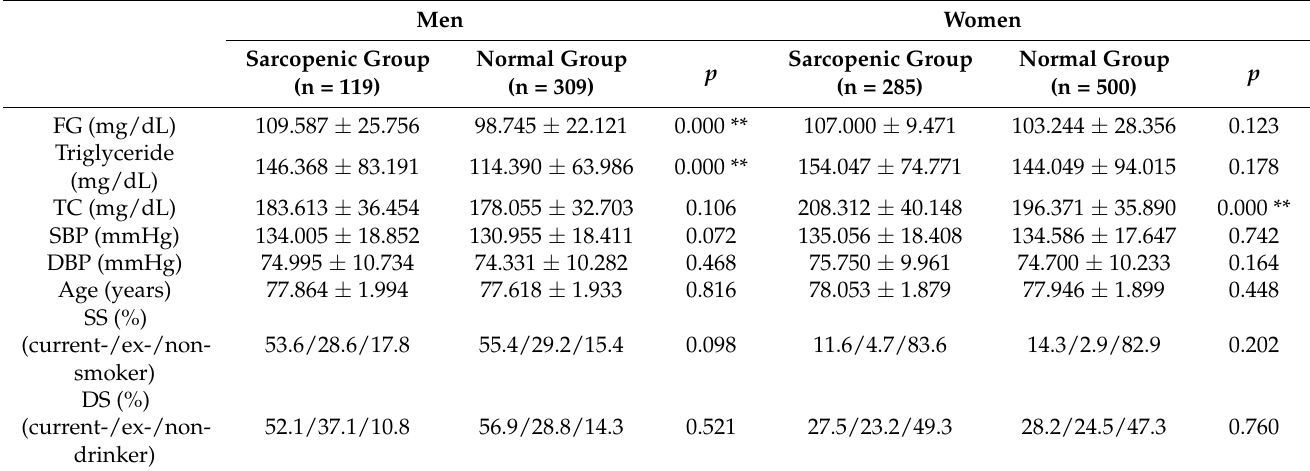
Table 4. Gender-specific risk factors in blood tests, blood pressure, and other survey variables.